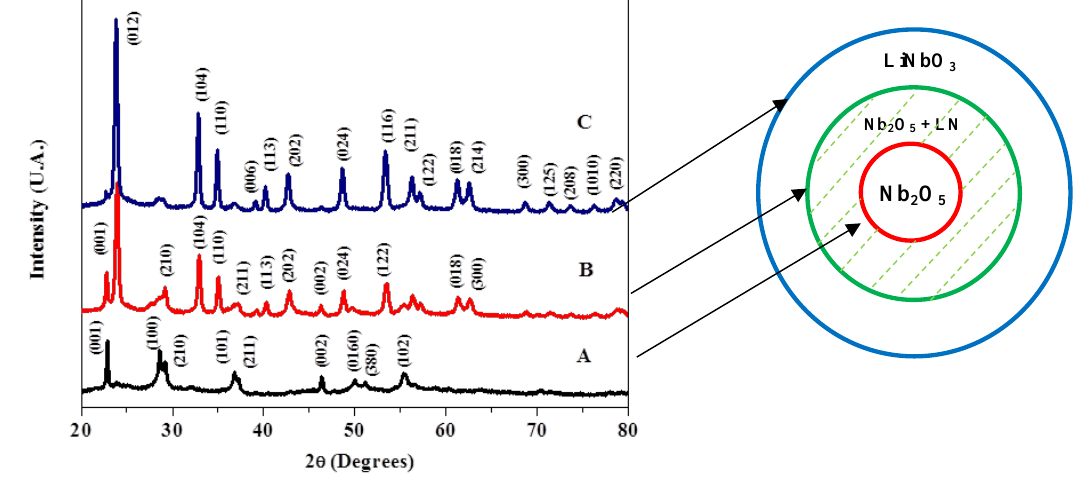
Figure 2. Powder XRD for samples prepared at 300 min of milling and corresponding to calcination temperatures at ( A ) 350 °C, ( B ) 450 °C and ( C ) 650 °C. Inset: three phases